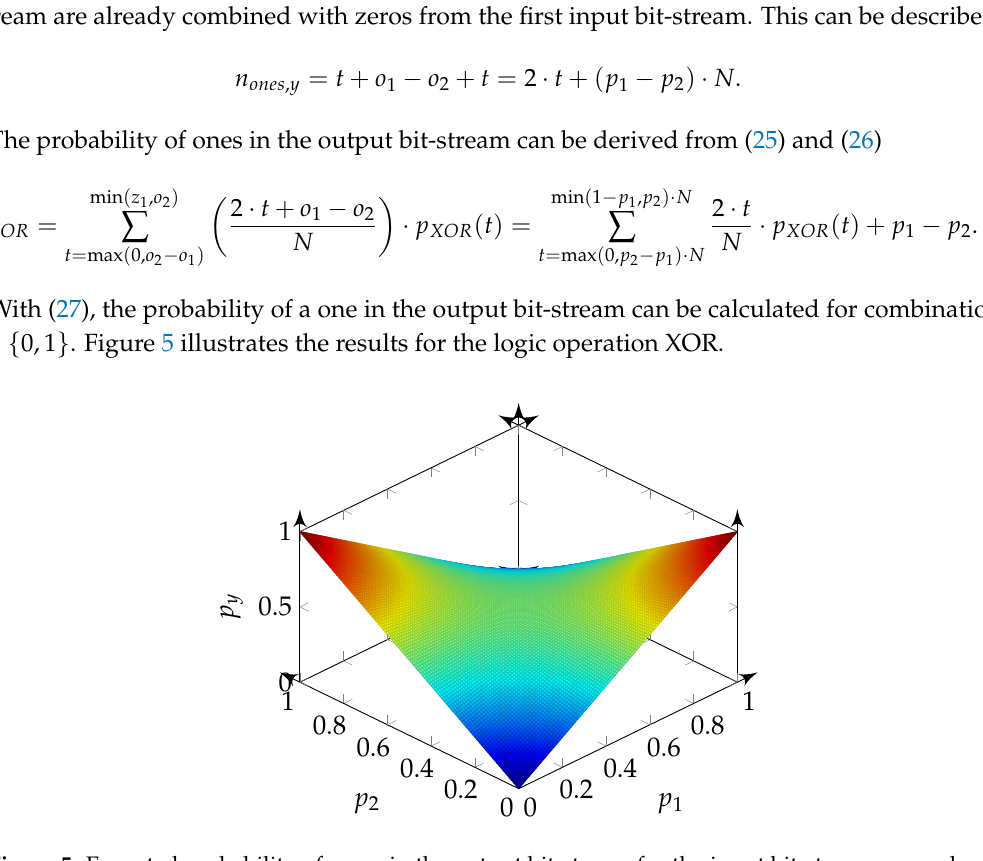
Figure 5. Expected probability of a one in the output bit-stream for the input bit-streams x 1 and x 2 , with the probability of ones p 1 2 , operated by |